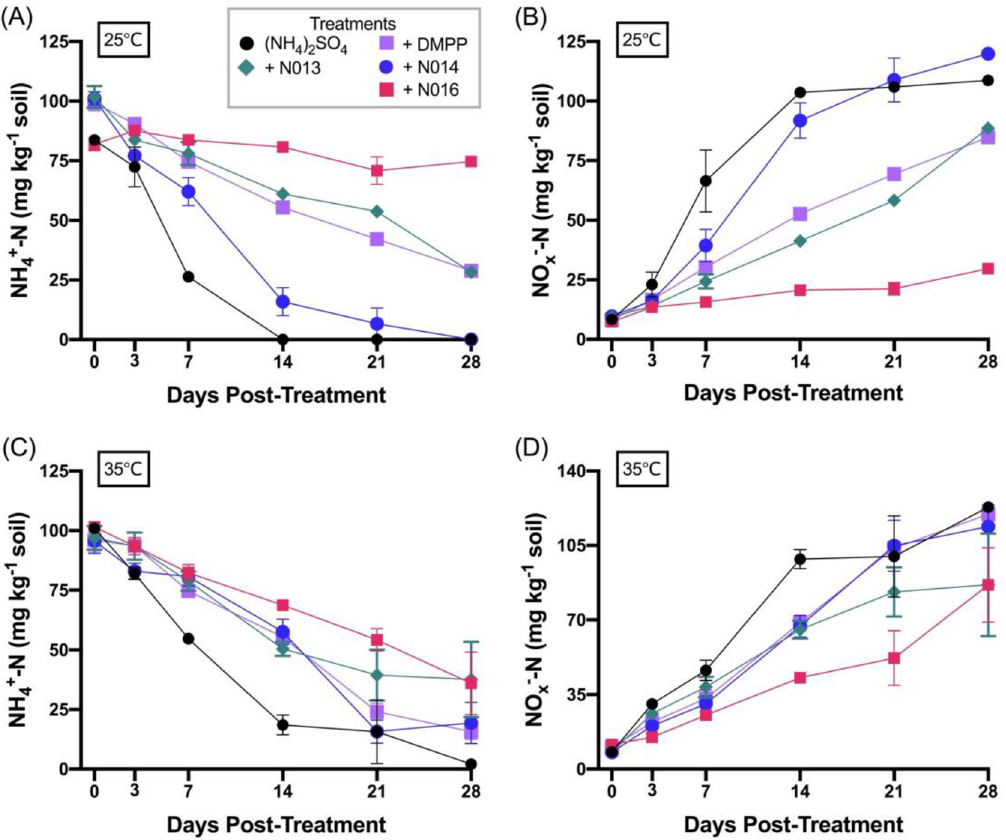
Figure 3. Measured NH 4 + -N ( A , C ) and NO x – -N ( B , D ) concentrations of Horsham soil incubated at 25 °C ( A , B ) and 35 °C ( C , D ) over 28 days following treatment with: (NH 4 ) 2 SO 4 [Black circle], (NH 4 ) 2 SO 4 + DMPP [Pink square], (NH 4 ) 2 SO 4 + N013 [ Green diamond], (NH 4 ) 2 SO 4 + N014 [Blue circle], (NH 4 ) 2 SO 4 + N016 [Violet square]. Inhibitors were applied at 10 mol% of fertiliser N. Data show the mean values (n = 3), errors are standard errors of the